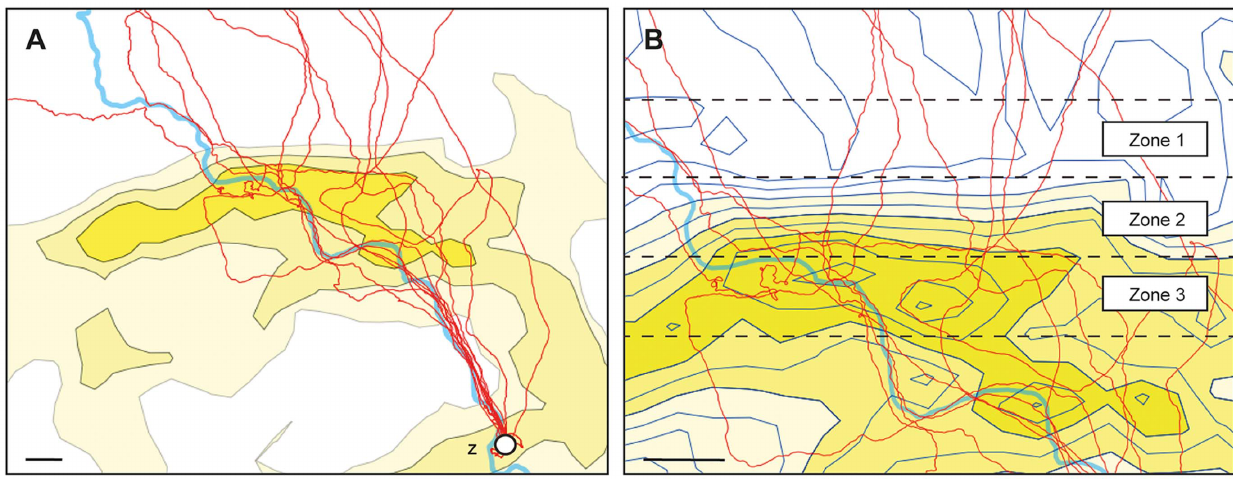
Figure 6. Flight tracks of Z-pigeons crossing the Bandurove anomaly. (A) Flight tracks of 11 Z-pigeons. Z depicts the home loft. The thick meandering blue line is the Bug river. The contour lines of the gravity anomaly (horizontal gradient) are in steps of 10 E. The brightness of the color denotes the anomaly intensity: light (E=20), middle (E=30), dark (E=40). 1 E=0.1 mGal/km. (B) Close-up of the same map but with blue contour lines in steps of 5 E. Zone 1: normal gravity area before the Bandurove anomaly; zone 2: gravity anomaly area with a steep change of the horizontal gravity gradient (isolines are close together); zone 3: the core anomaly area with continous values of 40–50 E. The bar in the lower left corner of both pictures represents 3 km.